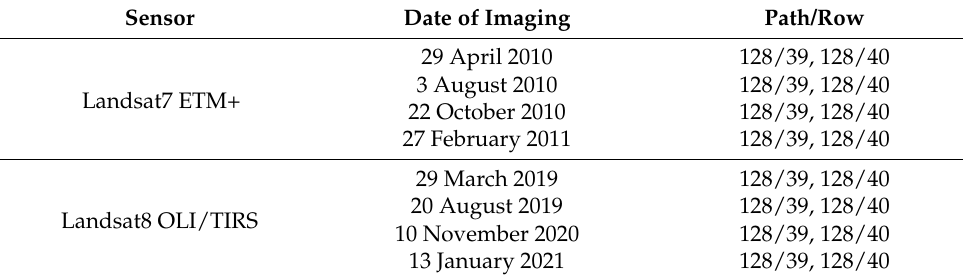
Table 1. Remote sensing image data